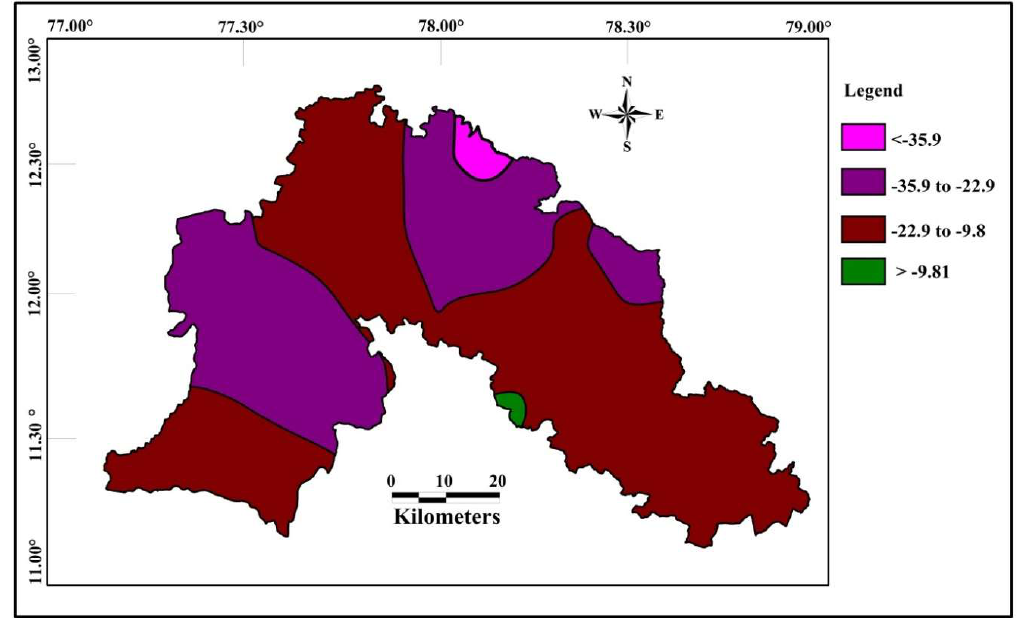
Figure 10. Spatial distribution of δD in the groundwater (in permil).